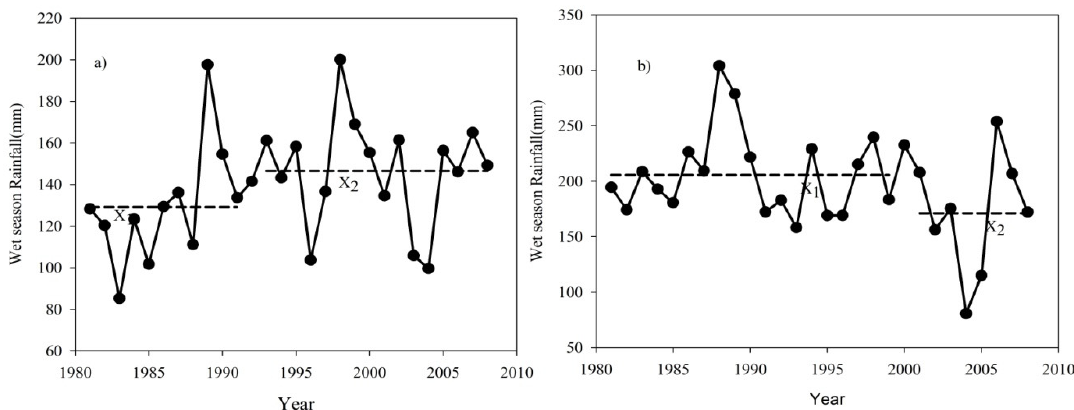
Figure 7. Seasonal rainfall time series plots with change point detection: ( a ) Wet season at Assendabo station, and ( b ) wet season at Shebe station. The dashed lines represented by X 1 and X 2 are the mean of the time series before and after the change point, respectively.